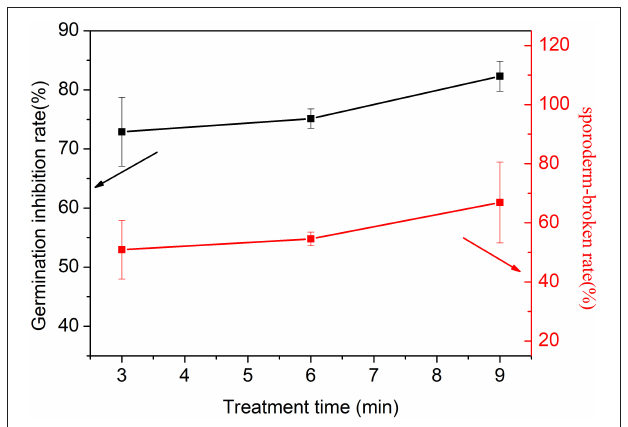
FIGURE 6 | Variations of the germination inhibition rate and sporoderm-breakage rate with the treatment time under 9.57mg L − 1 water content, − 6 kV voltage, 10min response time, and 5min storage time.